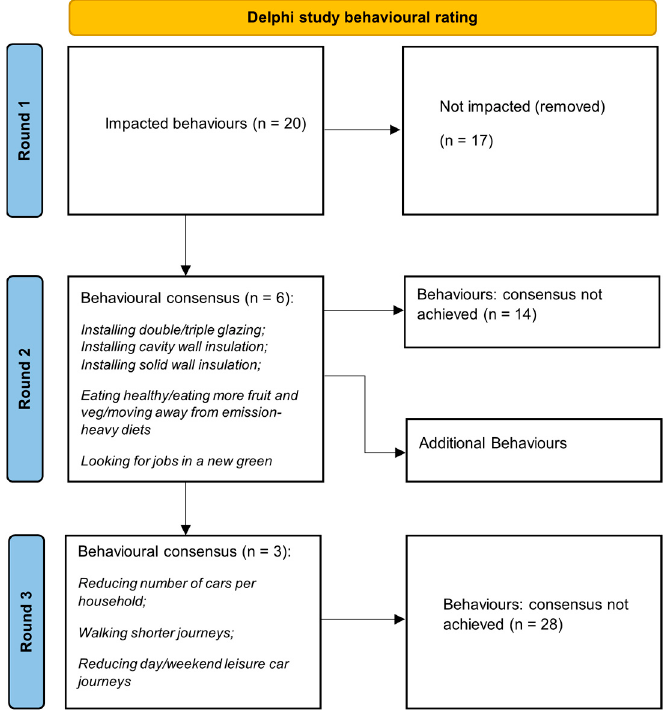
Figure 1. Delphi study Round 1–3 behaviour inclusion and